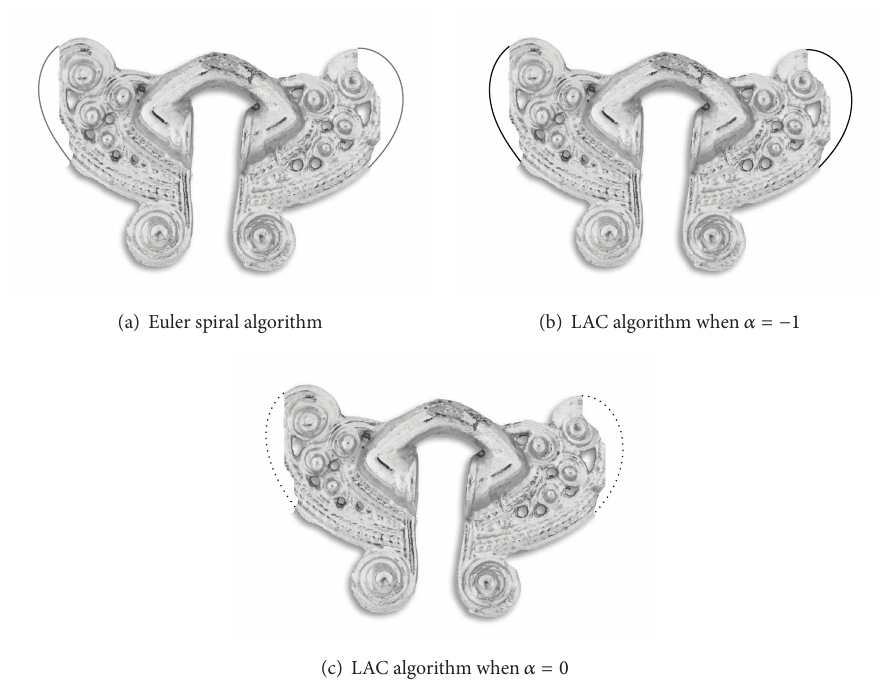
Figure 6: The results of fitting Euler spiral and LAC segment for an